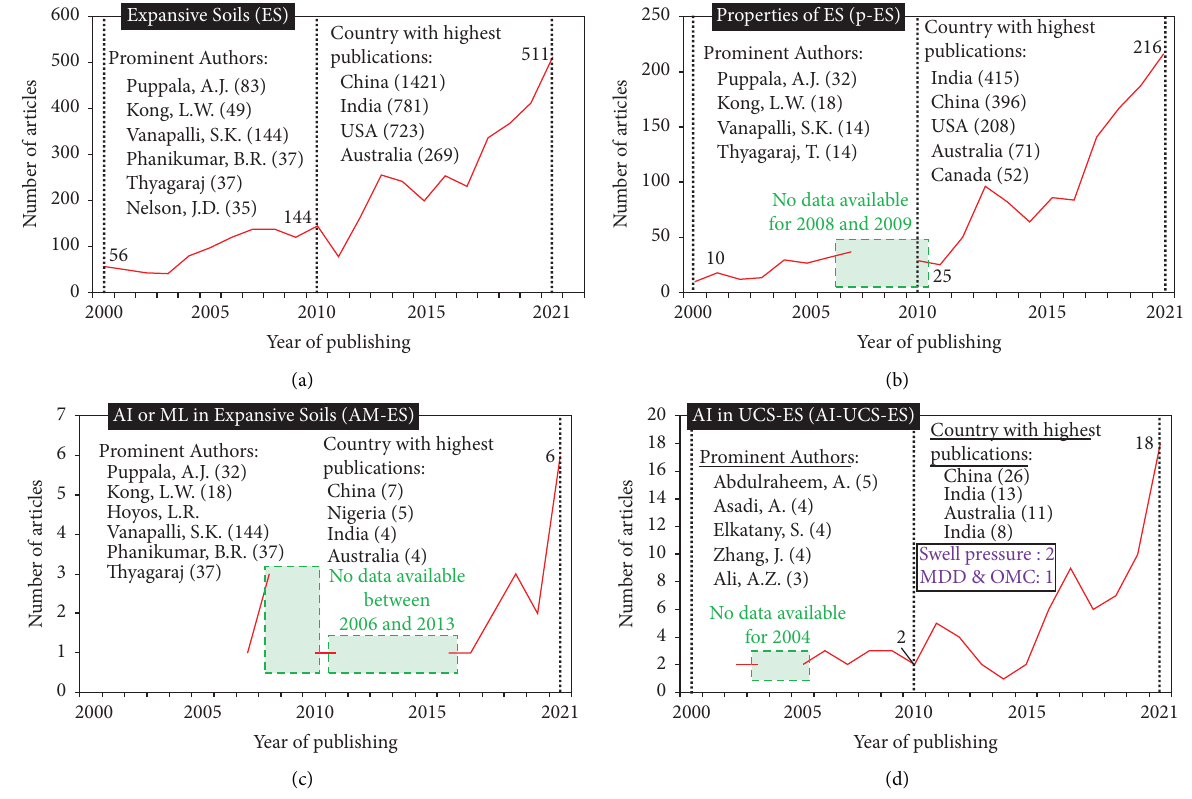
Figure 2: Year-wise research articles on expansive soils after 2000 using diferent key words; (a) expansive soils, (b) properties of expansive soils, (c) AI or ML in expansive soils, and (d) AI in UCS of expansive